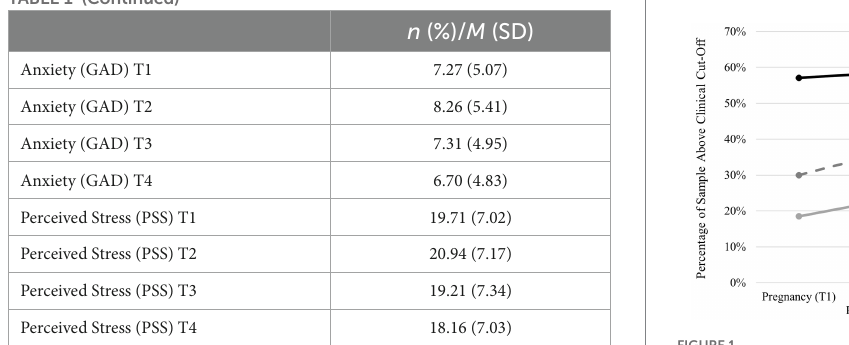
FIGURE 1 Percentage of the sample above the clinical cut-off for depression and anxiety across